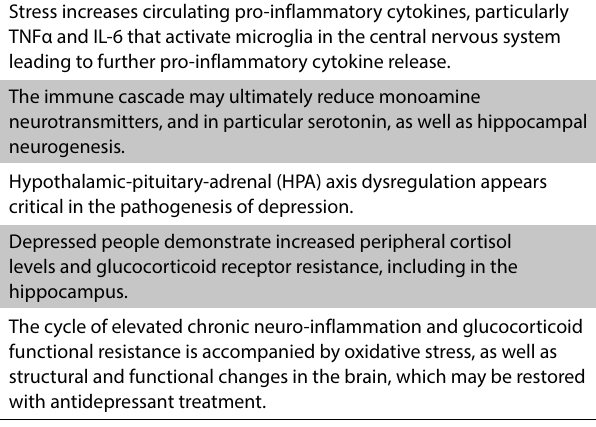
Table I: Is depression a stress-induced organic disorder? 9 Stress increases circulating pro-inflammatory cytokines, particularly TNFα and IL-6 that activate microglia in the central nervous system leading to further pro-inflammatory cytokine